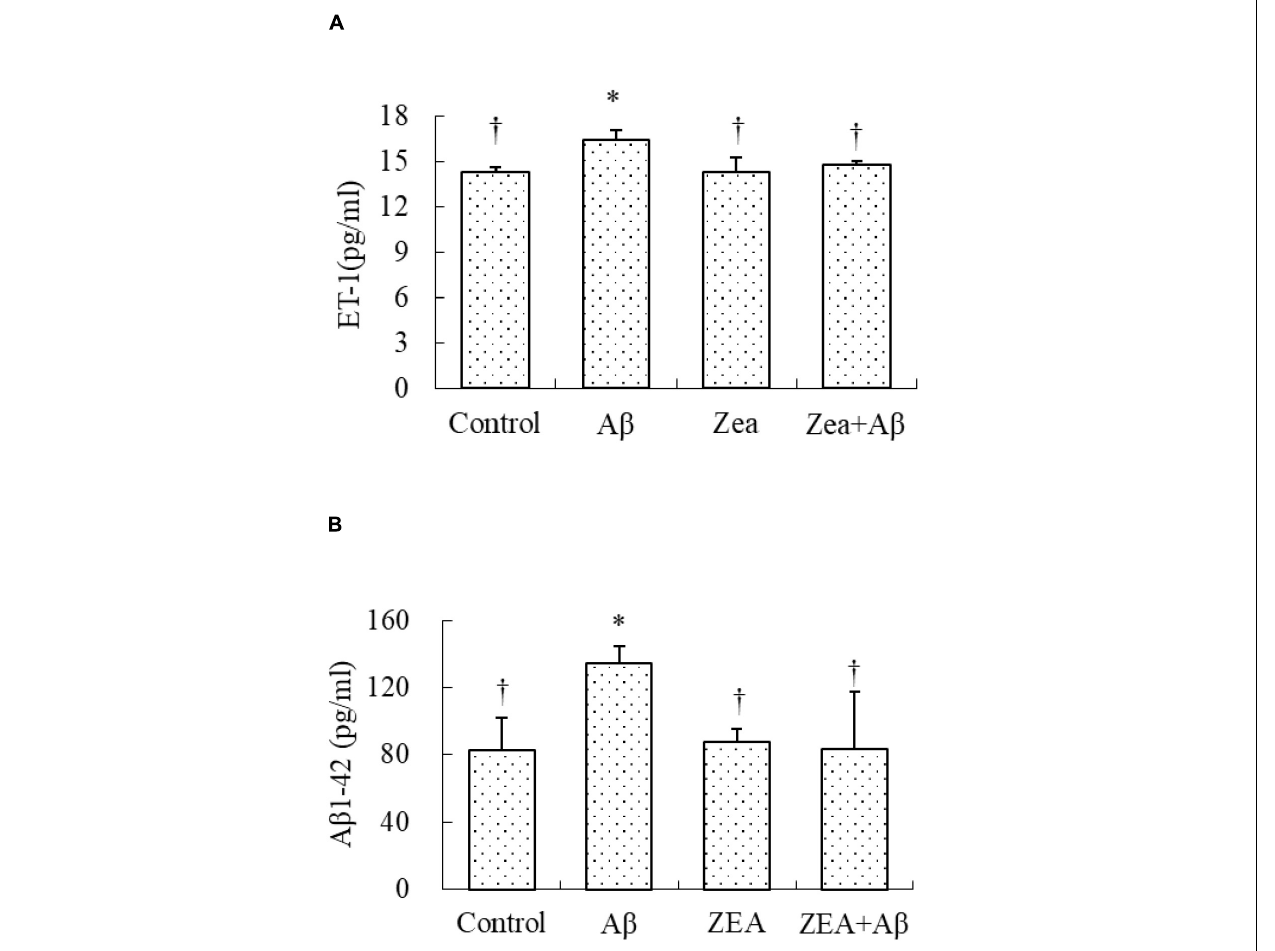
FIGURE 5 | Neuroprotective effects of ZEA on the level of ET1 (A) and the level of A β 1–42 (B) in plasma of learning and memory impairment rats induced by A β 1–42. ELISA was used in the rat plasma from four treatment groups mentioned before ( n = 12 per group). All the data were shown as mean ± SD, and analyzed by the one-way ANOVA test [ post hoc (LSD) test]. ∗ Significantly different from the Control group ( p < 0.05). † Significantly different from the A β group ( p <